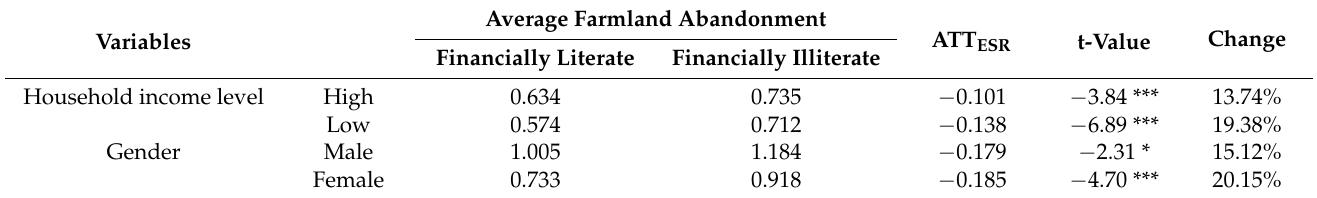
Table 5. Disaggregated effect of financial literacy on farmland abandonment by household income and gender